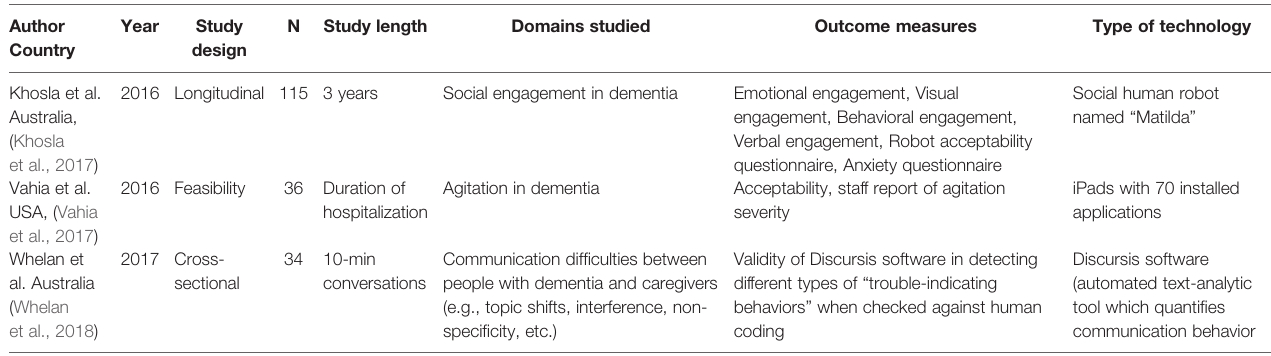
TABLE 5 | Studies utilizing other technologies.